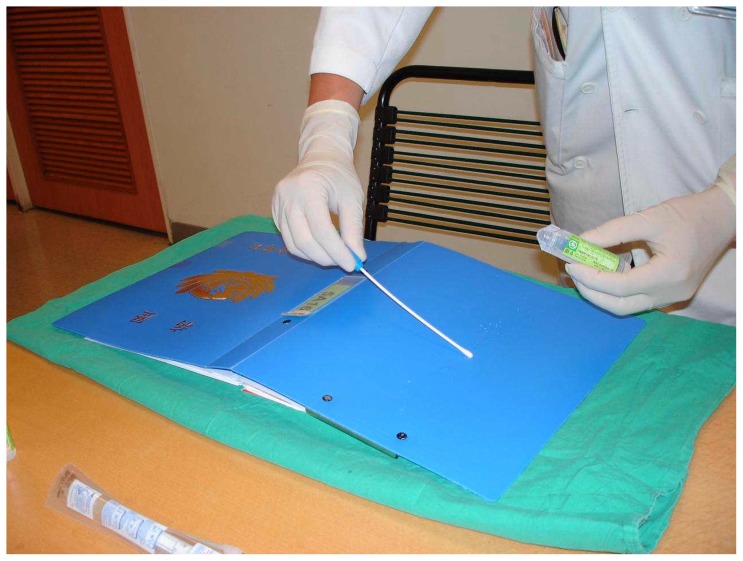
Sampling of a hospital medical chart.The sample was collected from the entire outer surface (plastic cover) of a hospital medical chart with a sterile cotton swab rinsed by normal saline after the experienced investigator had worn sterile gloves.